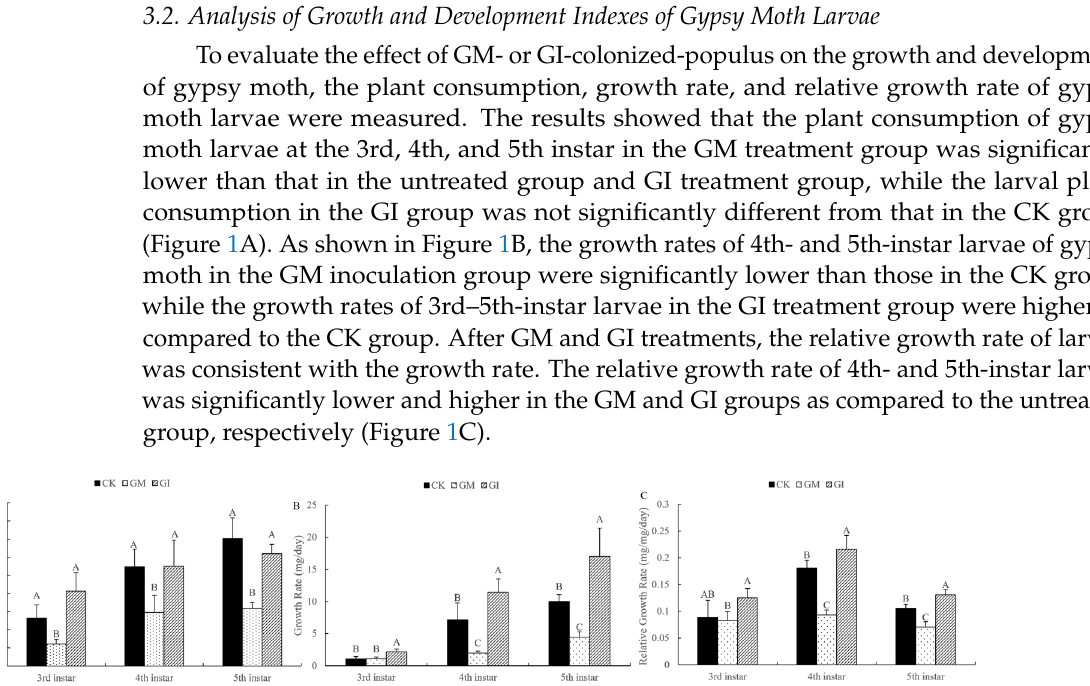
Figure 1. The plant consumption ( A ), growth rate ( B ), and relative growth rate ( C ) of the 3rd-, 4th-, and 5th-instar gypsy moth larvae fed on the leaves of GM, GI, or nonmycorrhizal-colonized poplar plants. Different capital letters indicate significant differences among groups ( p < 0.05).